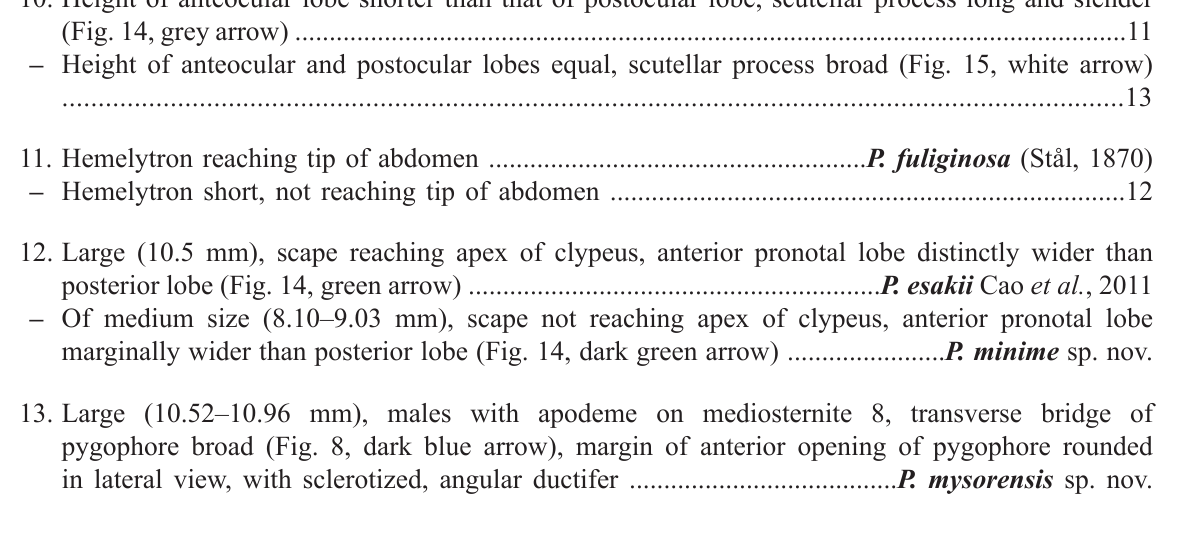
hemelytral membrane basally dark brown, apically off-white ........................... P. tricolor sp. nov. Length of anterior pronotal lobe equal to that of posterior lobe, anterior lobe higher than posterior lobe in lateral view, membranous portion of hemelytron uniformly brown .................................... 10. Height of anteocular lobe shorter than that of postocular lobe, scutellar process long and slender (Fig. 14, grey arrow) .........................................................................................................................11 – Height of anteocular and postocular lobes equal, scutellar process broad (Fig. 15, white arrow)